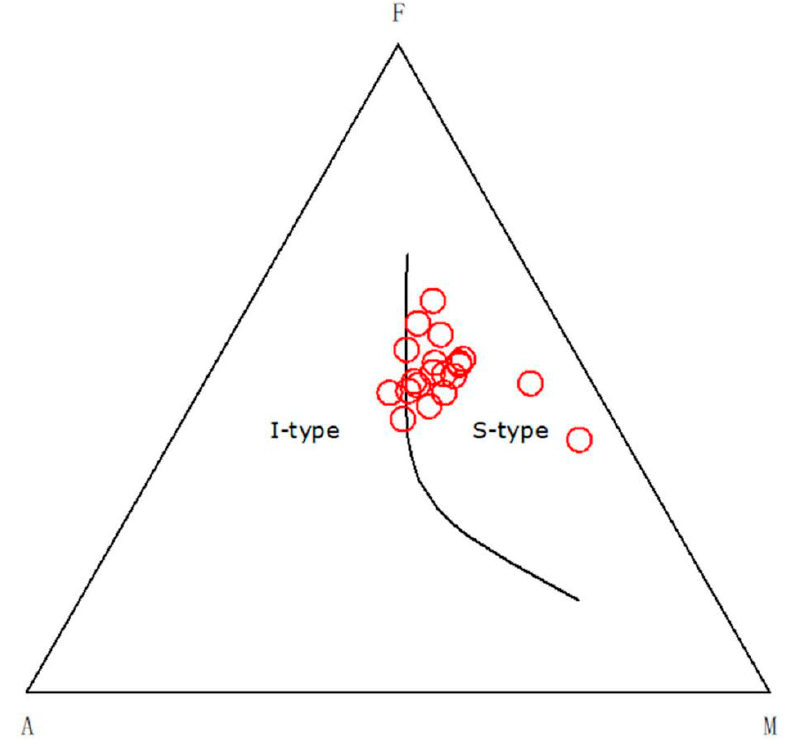
Figure 8. S- and I-type granite discrimination diagram for the Dahongliutan pluton samples (ac- cording to Nakada, et al. [48]). A = n (Al 2 O 3 − Na 2 O − K 2 O); C = n (CaO − 3.33 P 2 O 5 ); F = n (FeO + MgO + MnO).